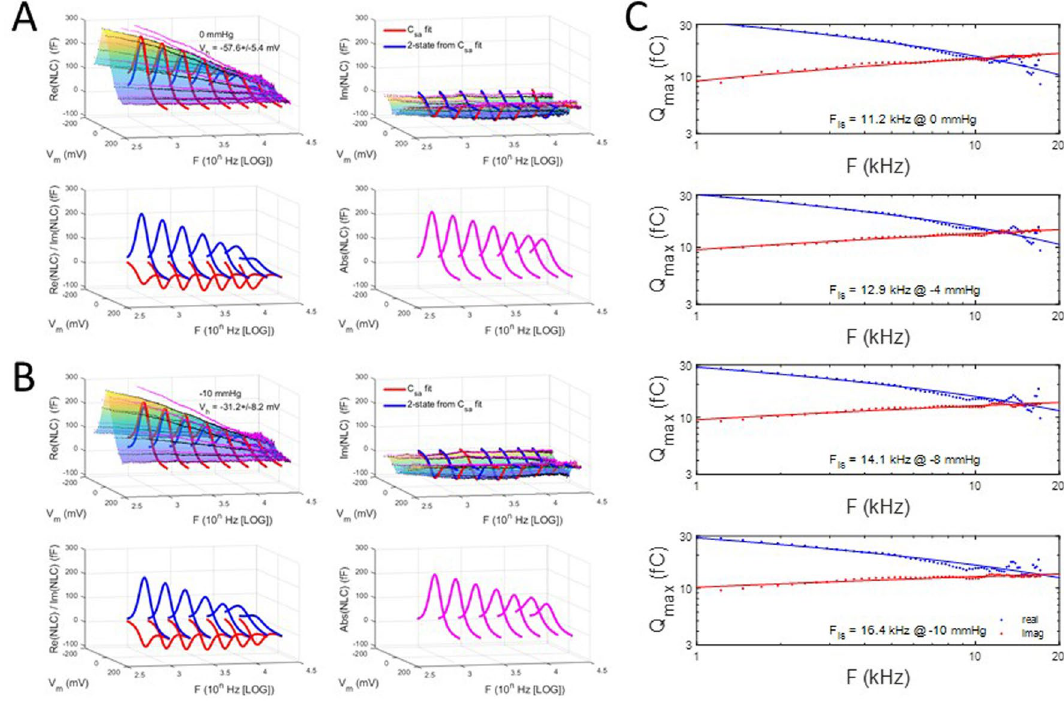
Figure 9. Membrane tension effects on the frequency response of complex capacitance for negative initial V h . (A) 0 mmHg, (B) − 10 mmHg. Clear changes, especially in the imaginary component, are noted between the two tensions. These changes are highlighted in (C) where the intersection frequency, F is , is found to increase with increases in tension. A shift from 11 to 16.2 kHz occurs between the two